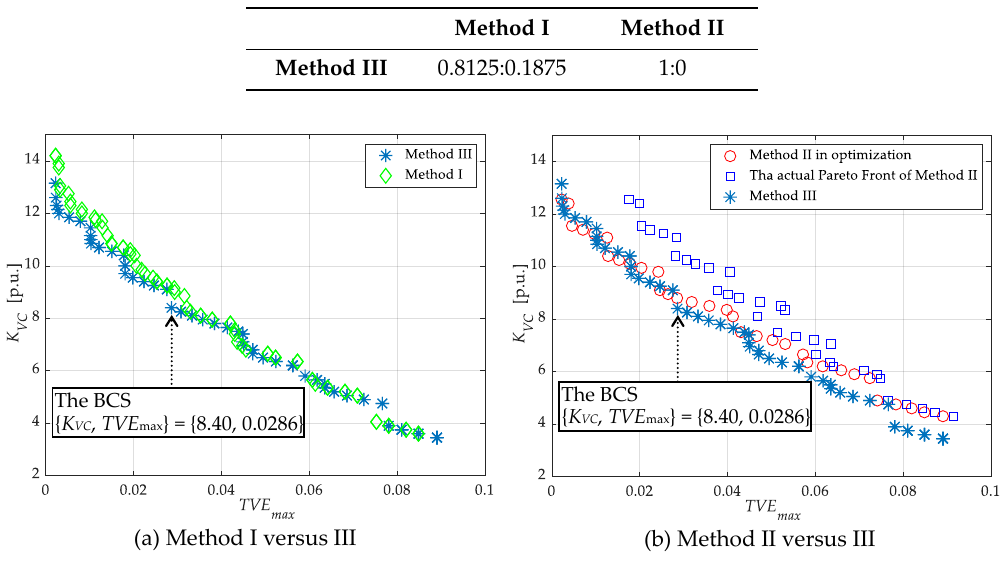
Table 4. Ratio of Non-dominated Individuals (RNI) calculation.